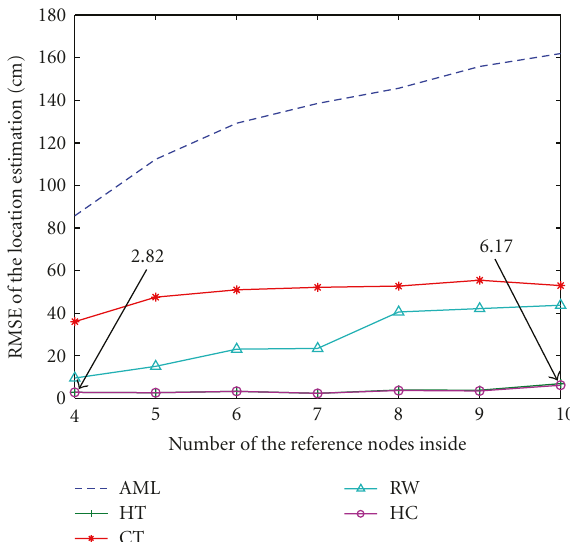
Figure 7: Performance of the methods depending on the total number of reference nodes. The number of the LOS nodes is random but at least three. Simulation performed with 1000 trials.